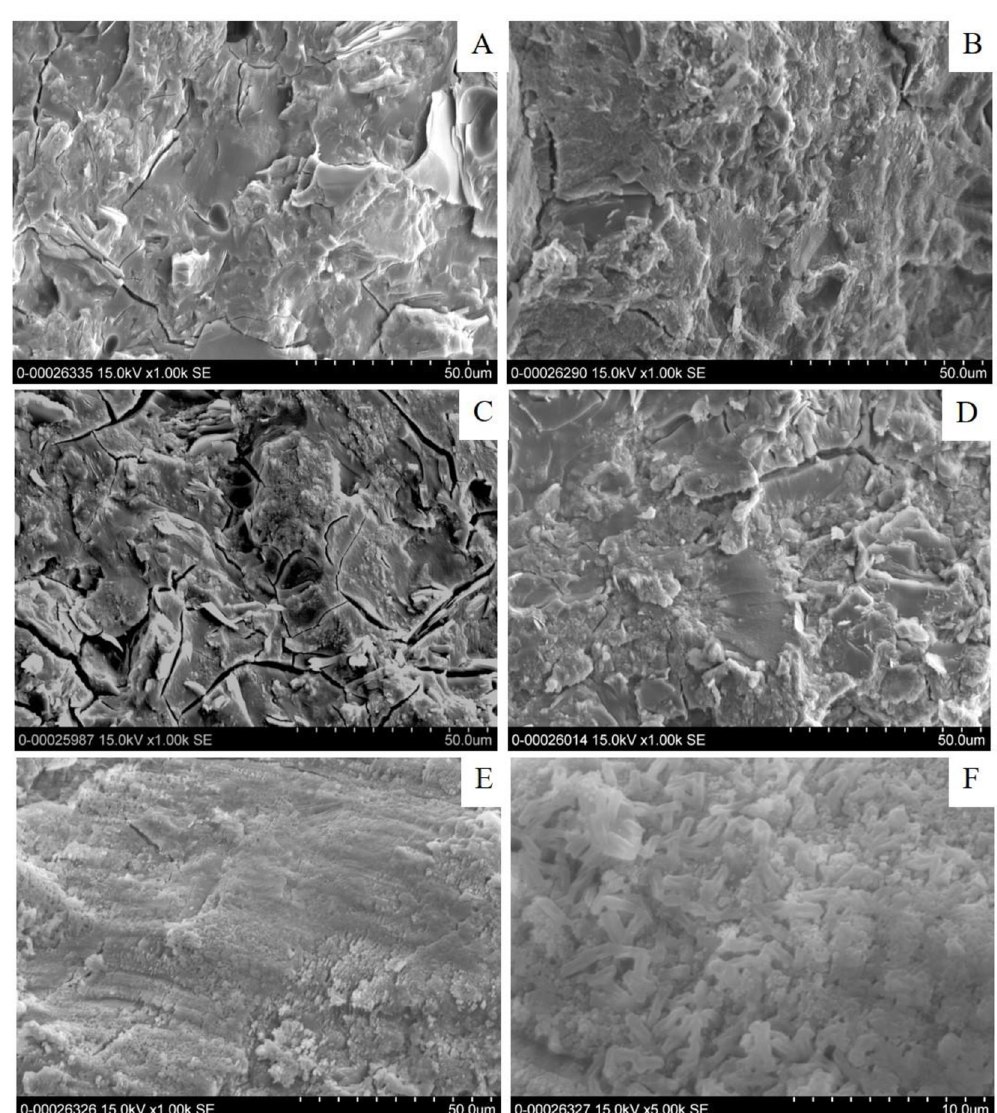
Fig 6. FE-SEM photomicrographs of MK-based geopolymer containing different amounts of TiO 2 /zeolite (A) 0%, (B) 10%, (C) 20%, (D) 30%, (E) and (F) 40 wt%.